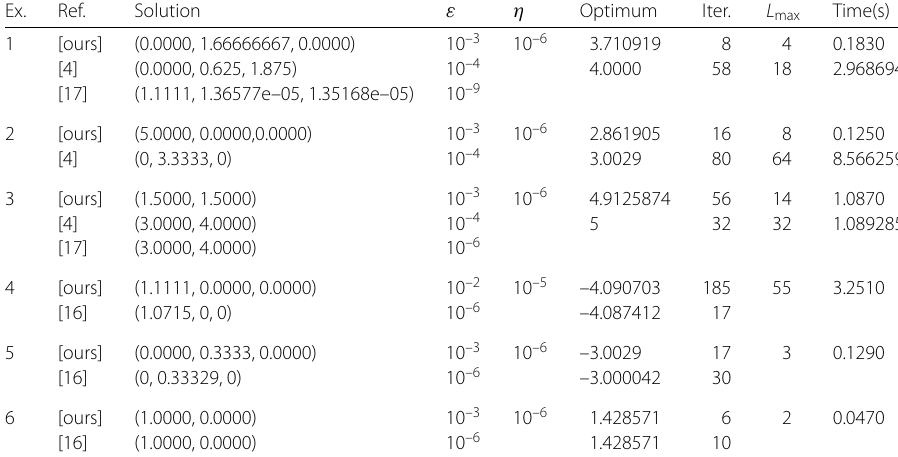
Table 1 Computational results for Examples 1–6